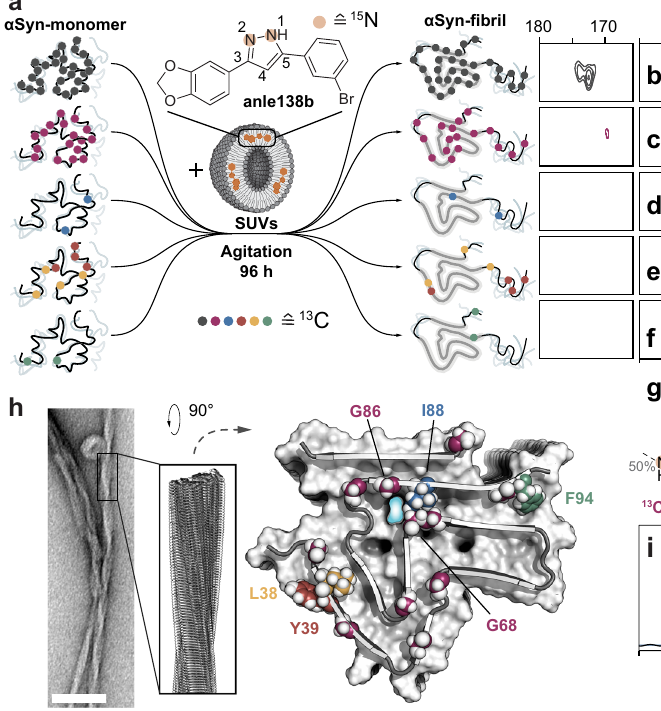
acids used for speci fi c isotope labeling with 13 C- labeled nuclei indicated by colored circles(sameasin a )and 15 N-labelingindicatedbyorangecircles. h NegativestainEM micrograph of fi brils grown in the presence of lipids (scale bar 100nm) alongside cryo-EM structure of α -synuclein proto fi lament L2 20 with color coding of speci fi c isotope-labeled residues. i Frequency selective REDOR spectrum (carrier frequency at 26 ppm, Supplementary Table 2) of Ile-labeled α -synuclein fi brils in the presence of1,2- 15 N-anle138b.Thedifferencespectrum( Δ S )isscaledup10-foldwithrespectto the reference spectrum ( S 0 ) for clarity. Fibrils were prepared at a lipid to protein to anle138b molar ratio of 10:1:0.5. Allspectra were recorded at 600MHz at 100K(see Supplementary Table 1) in the presence of